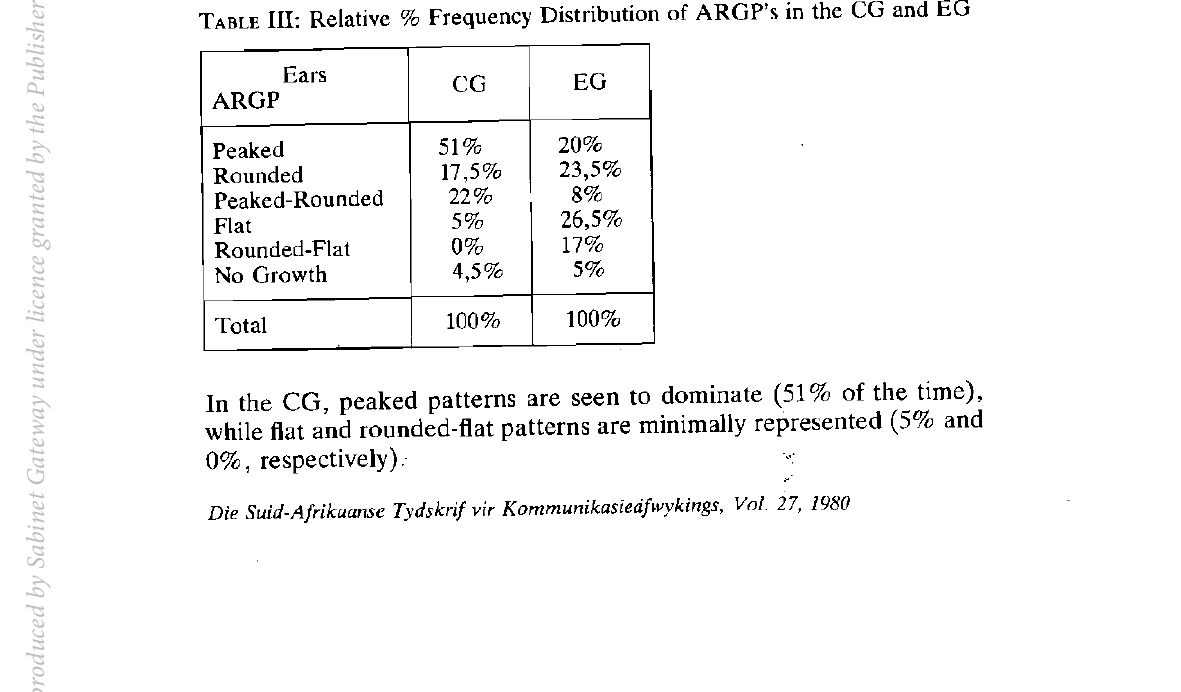
TABLE III: Relative % Frequency Distribution of ARGP's in the CG and EG Ears CG EG ARGP Peaked 51% 20% Rounded 17,5% 23,5% Peaked-Rounded 22% 8% Flat 5% 26,5% Rounded-Flat 0% 17% No Growth 4,5% 5% Total 100%